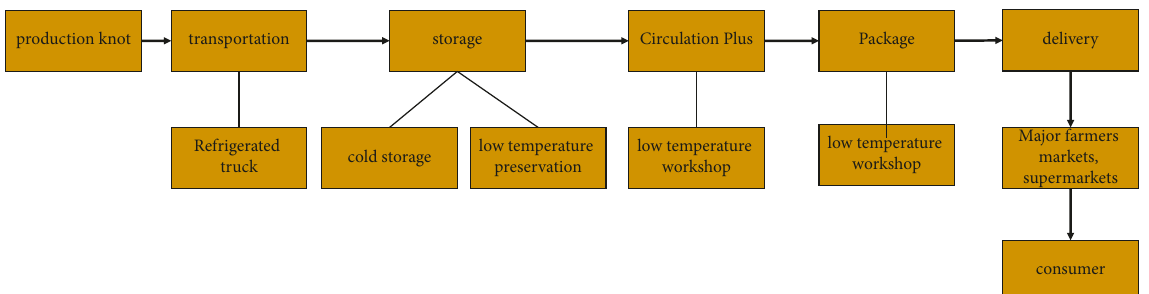
Figure 5: The complete process of cold chain logistics of fresh